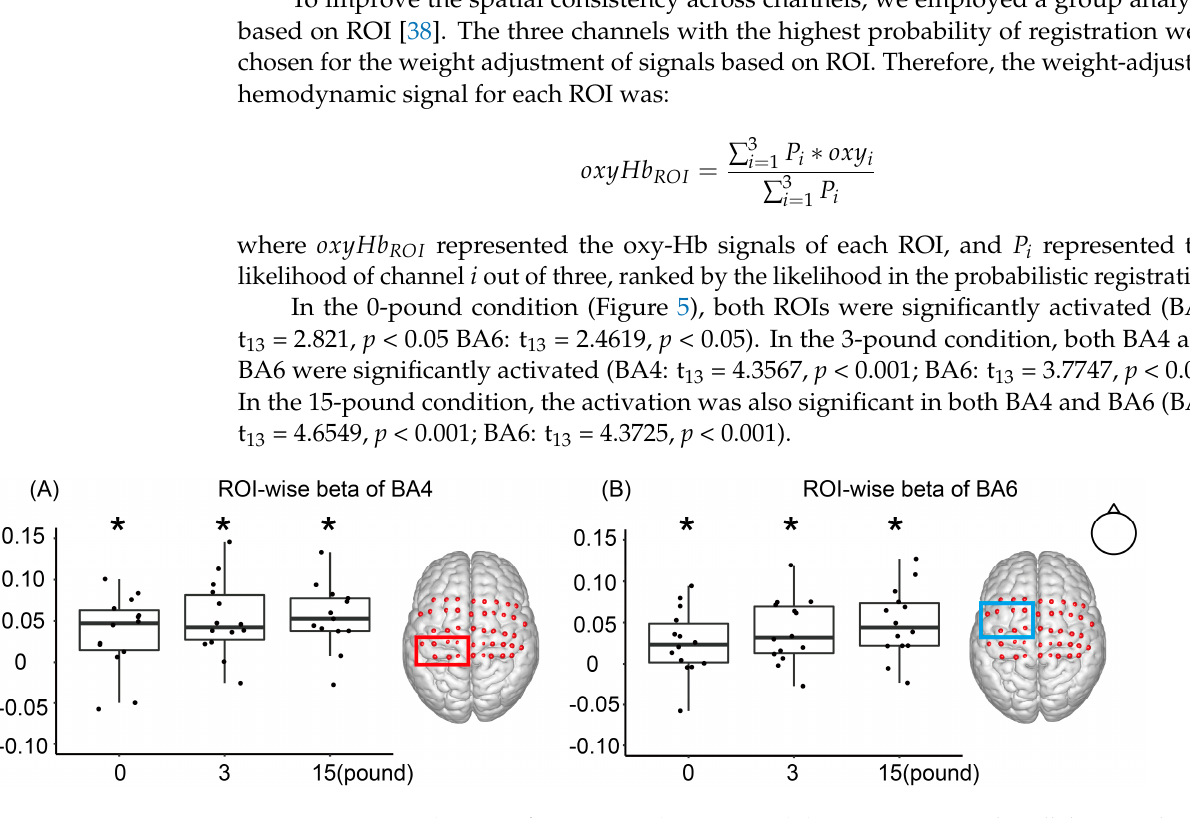
Figure 4. Averaged beta on a standardized brain model (n = 1 4 ). ( A ) The 0 − pound condition, in